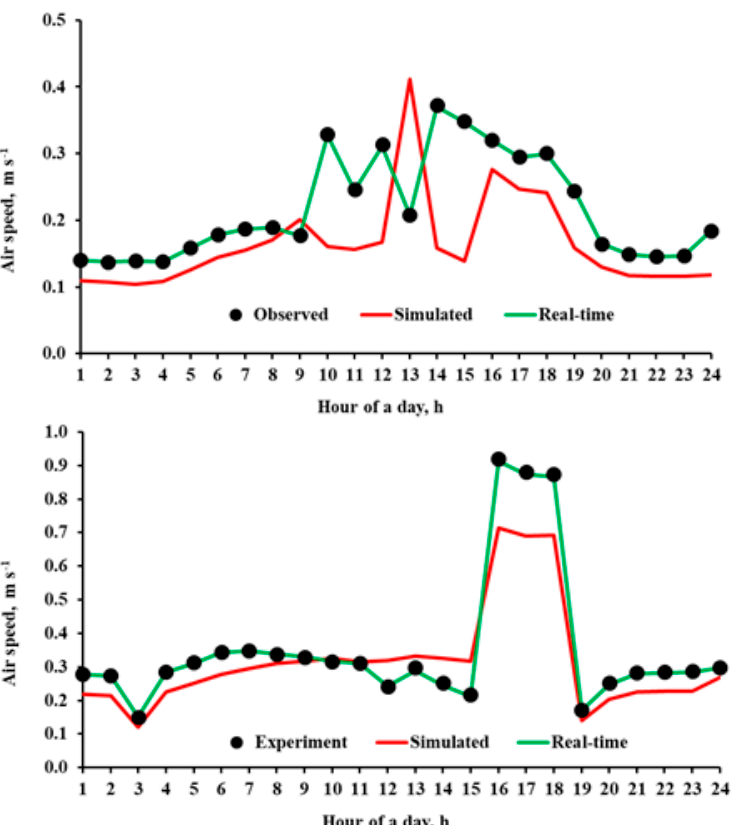
Figure 7. Comparison of observed, simulated, and real-time air speeds at two sensor positions during 24 h.